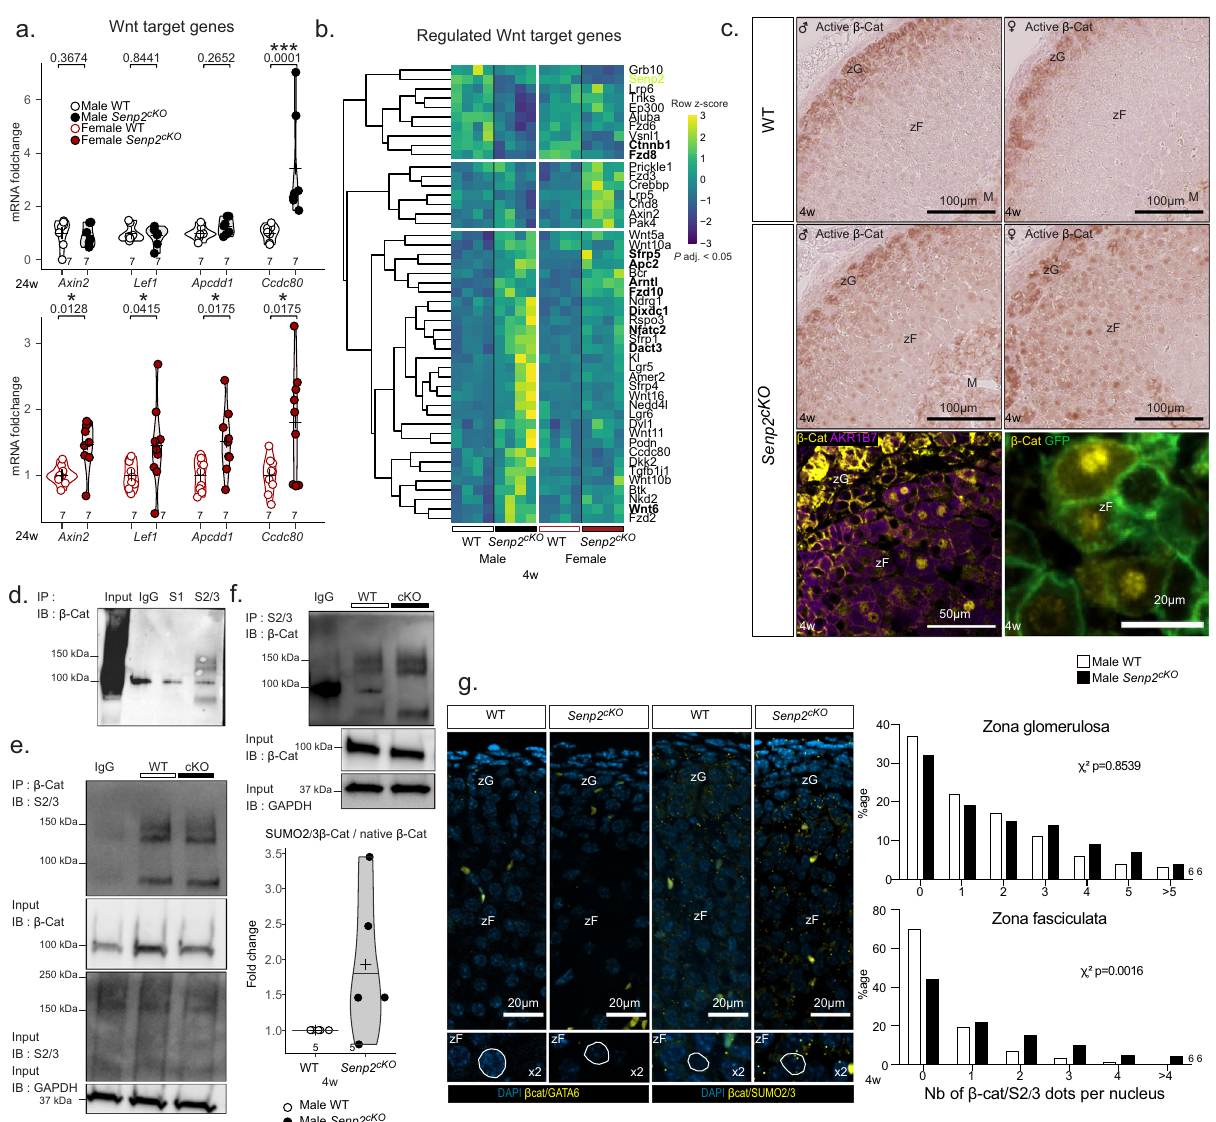
Fig. 8 | Senp2 loss promotes β -catenin SUMOylation and activates the WNT signalling pathway. a qPCR analysis of β -catenin target genes Axin2 , Lef1 , Apcdd1 and Ccdc80 mRNA accumulation in 24-week-old WT and Senp2 cKO mice. P values were determined by two-sided t test for normally distributed condition or two- sidedMann – Whitneytest. b HeatmapofdysregulatedWNTtargetgenesin Senp2 cKO male or female adrenals RNA-seq (adjusted P value < 0.05). Commonly dysregu- lated genes in males and females are represented in bold characters. c Top: Immunohistochemistry analysis of active (non-phospho) β -catenin on WT and Senp2 cKO male (left) and female (right) adrenals. Bottom: immuno fl uorescence staining of β -catenin (yellow) with zF marker AKR1B7 (purple) and GFP (green). d Immunoprecipitation assay depicting the interaction between β -catenin and